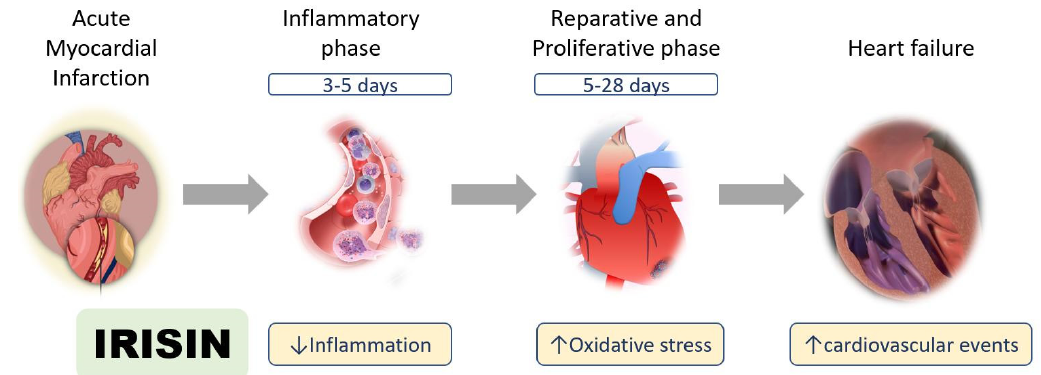
Figure 2. Roles of irisin in myocardial ischemia. Irisin has multiple functions after myocardial infarction in the inflammatory, reparative, and proliferative phases.